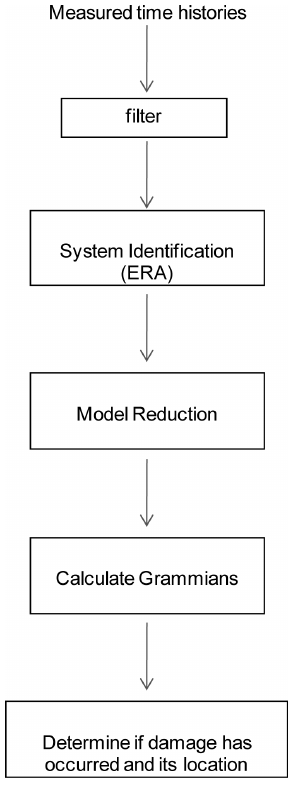
Fig. 1. Diagram showing the steps in characterizing